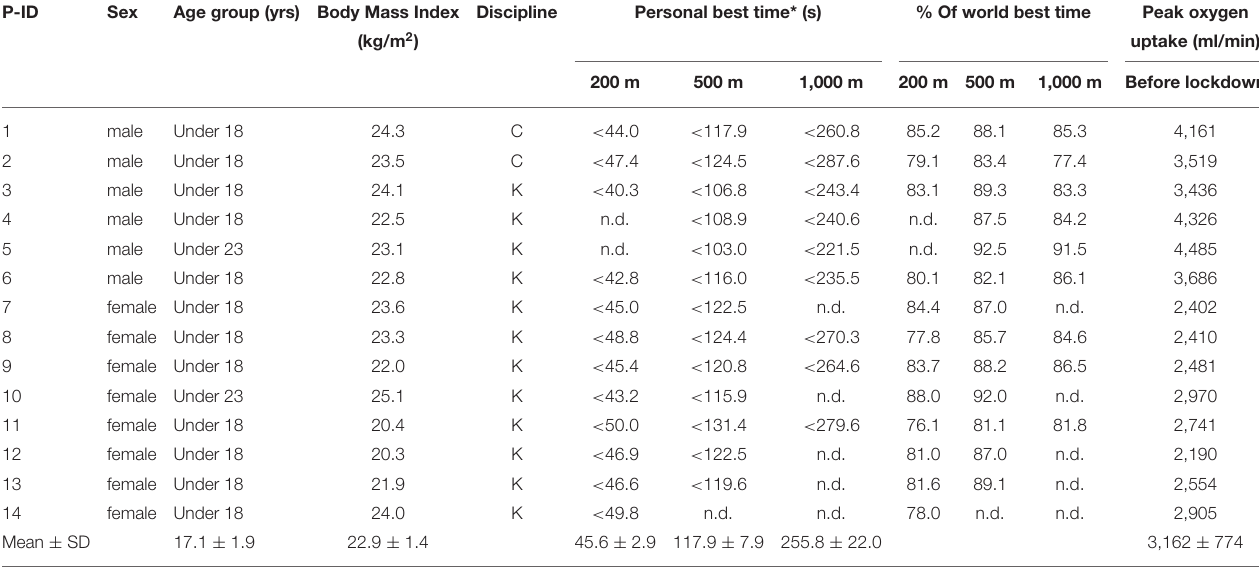
TABLE 1 | The sex, age, body mass index, discipline ( C = canoe, K = kayak), personal best times*, and peak oxygen uptake before lockdown (*best competition time from season 2019; n.d. = not determined).